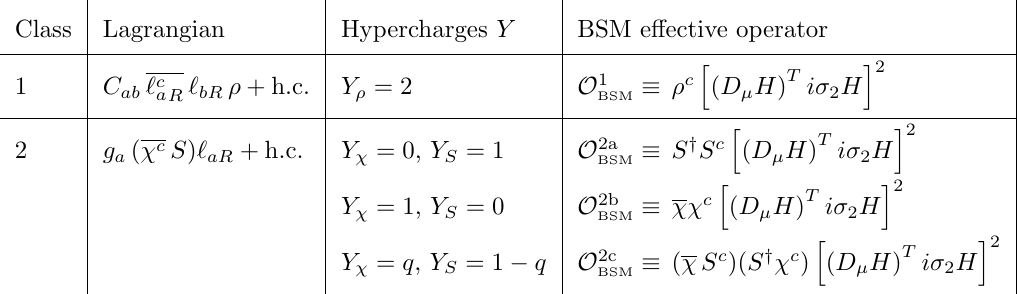
in eq. (2.1) can be divided O 9